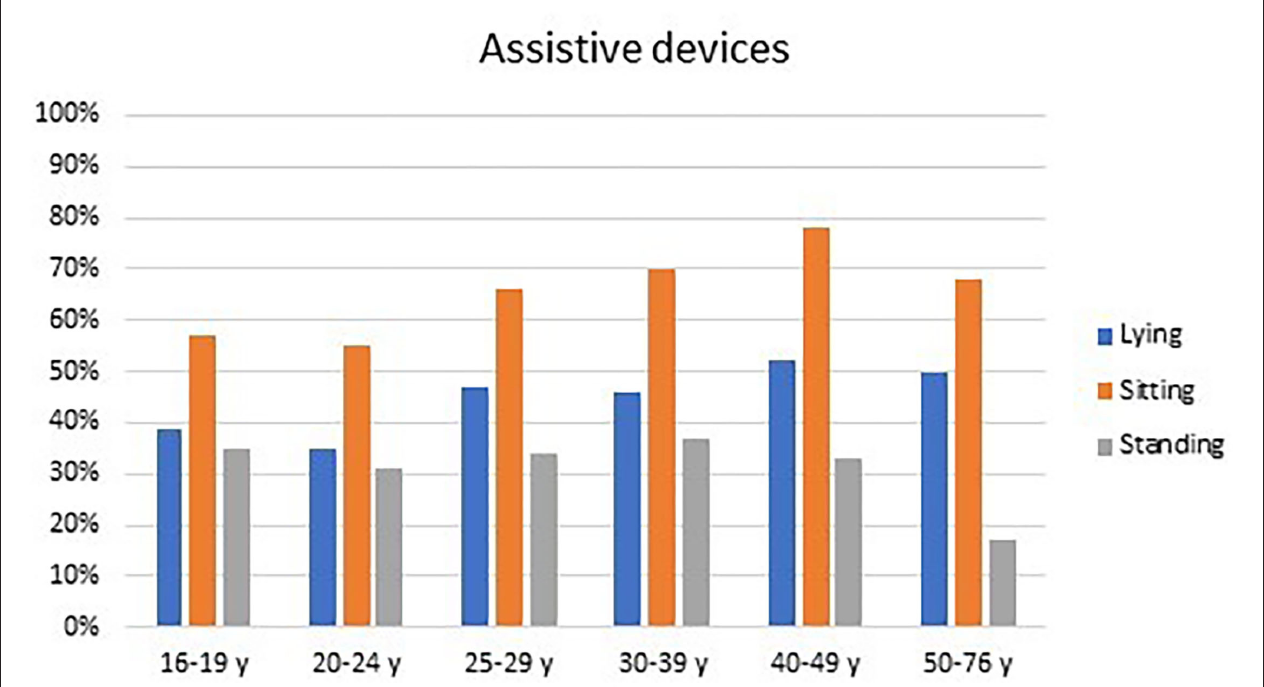
FIGURE 1 | Assistive devices used in lying, sitting, and standing by adults at different age groups.